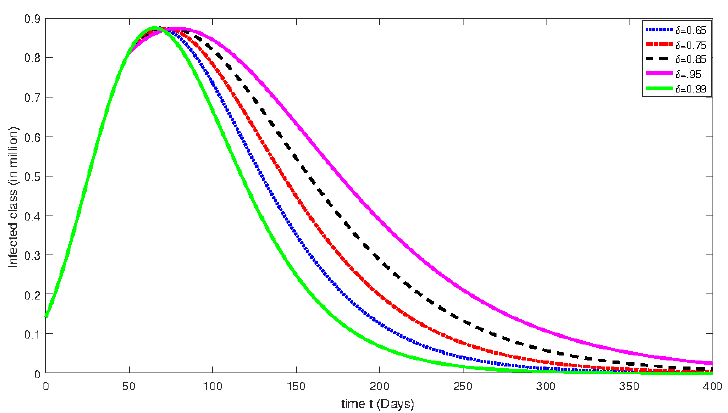
Figure 5. Numerical solution for susceptible class for the given days and using different fractional orders with isolation rate of 50%.